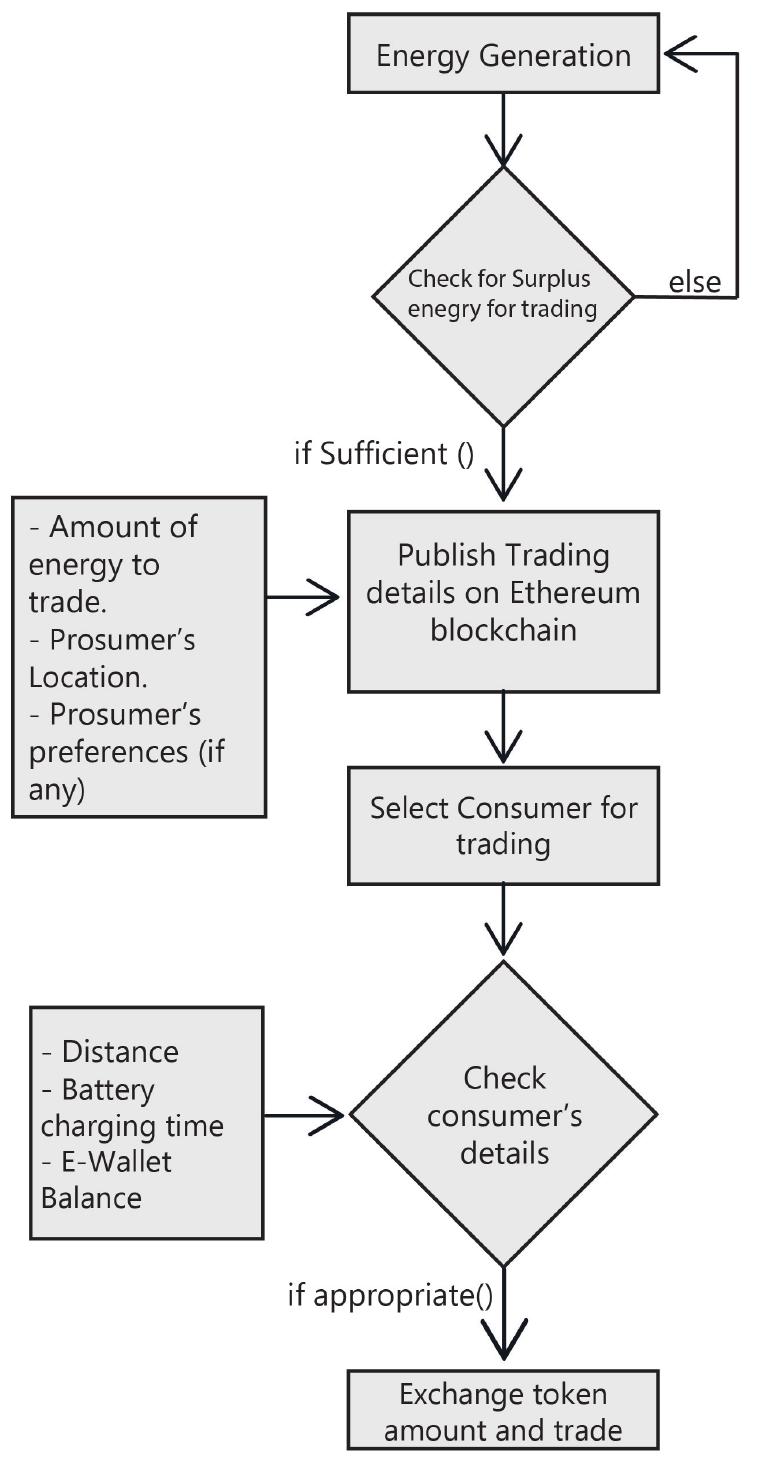
Figure 3. The workflow of the proposed DT-P2PET